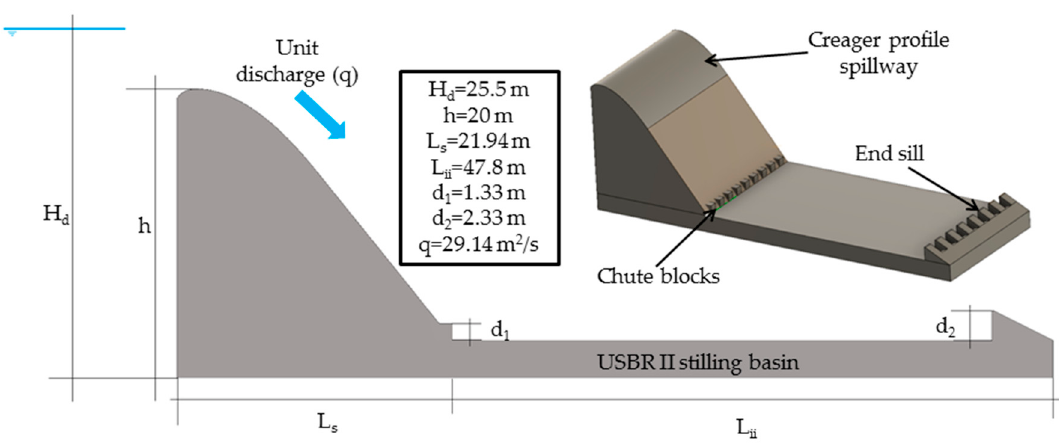
Figure 1. Case study: Creager profile spillway and United States Bureau of Reclamation Type II (USBR) type II stilling basin with the basic information regarding flow conditions and dimensions.